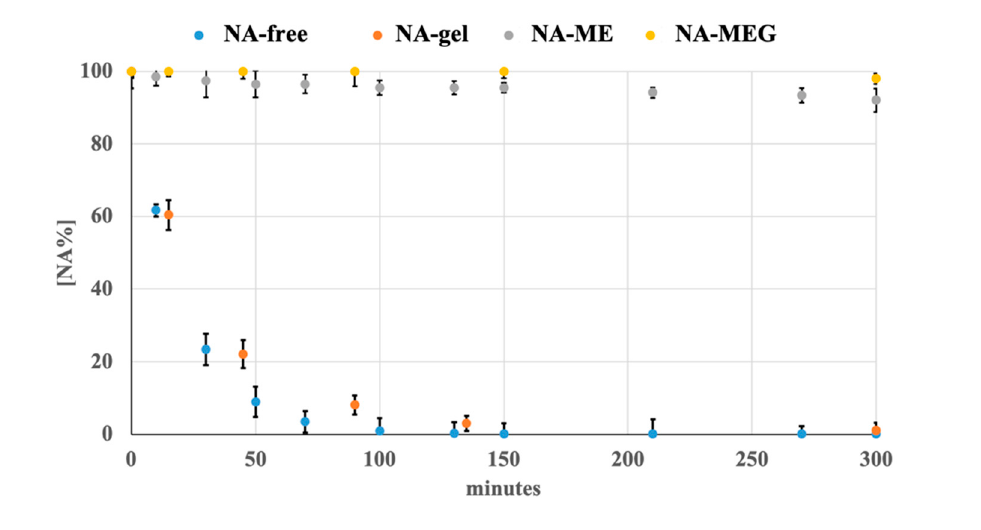
Figure 4. Photodegradation profiles of NA and A in all the tested formulations. 3.4. Ex-Vivo Permeation Studies In order to evaluate the influence of the different formulations on the drug skin permeation, ex- vivo percutaneous experiments were carried out using a Franz cell diffusion system. The cumulative amounts of NA and its analog A permeated across rabbit ear skin were plotted as a function of time and reported in Figure 5a,b, respectively. Both drugs were able to permeate rabbit ear skin in vitro and the cumulative amount of permeated drug increased with the time for all the samples.